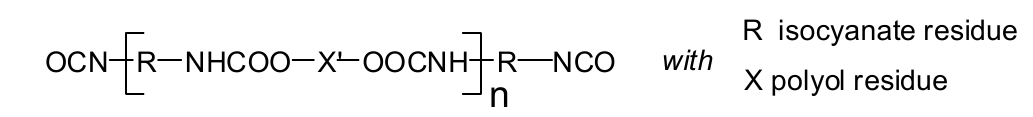
Scheme 6. Schematic representation of monocomponent PUR.